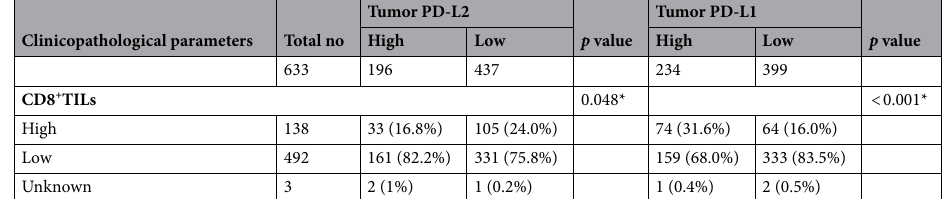
Clinicopathological parameters Total